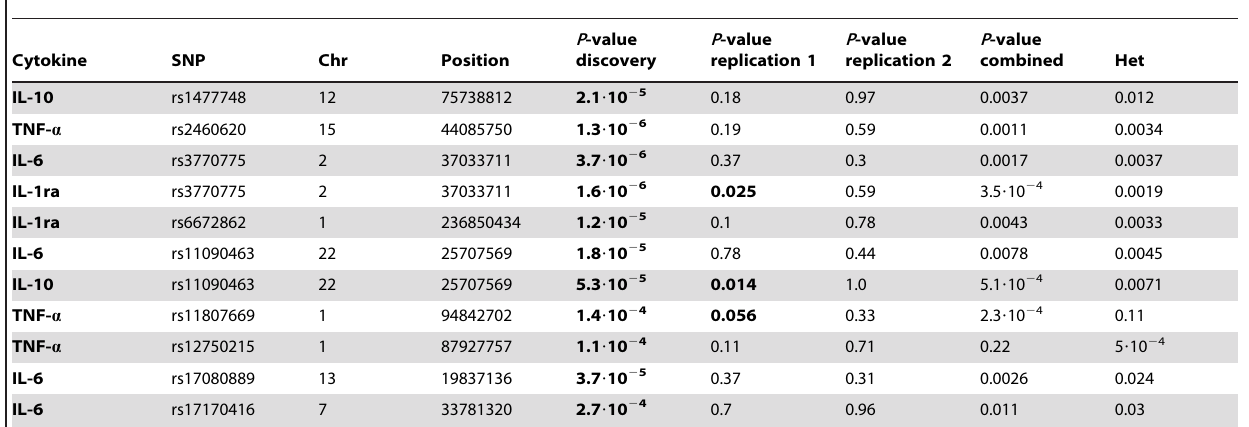
Table 2. Top 9 SNPs showing the highest evidence of association with IL-6, IL-8, IL-10, IL-1ra and TNF- a LPS stimulated plasma levels among healthy individuals with the most associated P -values , 5 6 10 2 5 in the discovery stage or P -values , 0.05 in the first replication stage ( n =